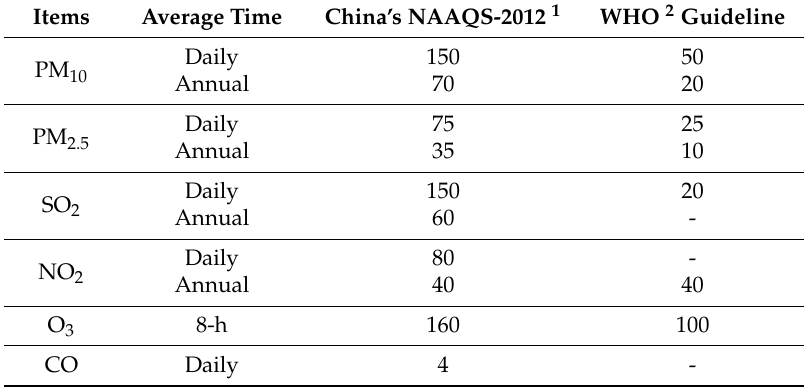
Table 2. Air pollutant standards for urban areas set by China and the World Health Organization (WHO) (the units for PM 10 , PM 2.5 , SO 2 , NO 2 and O 3 are µ g m − 3 , whereas that for CO is mg m − 3 ). Items Average Time China’s NAAQS-2012 1 WHO 2 Guideline Daily 150 50 PM 10 Annual 70 20 Daily 75 25 PM 2.5 Annual 35 10 Daily 150 20 SO 2 Annual 60 - Daily 80 - NO 2 Annual 40 40 O 3 8-h 160 100 CO Daily 4 - 1 MEP (2012a); 2 WHO